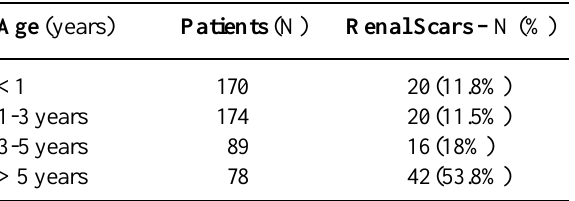
Table 3 – Patients with renal scars according to age at the presentation.